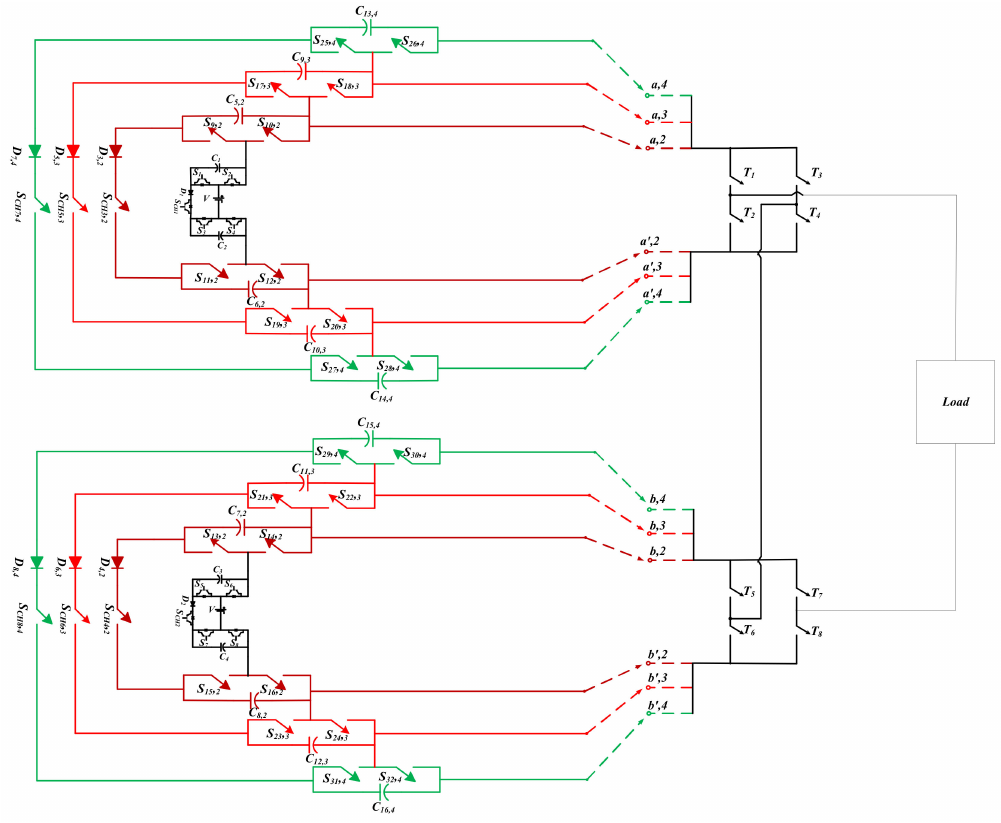
Figure 9. Extension of